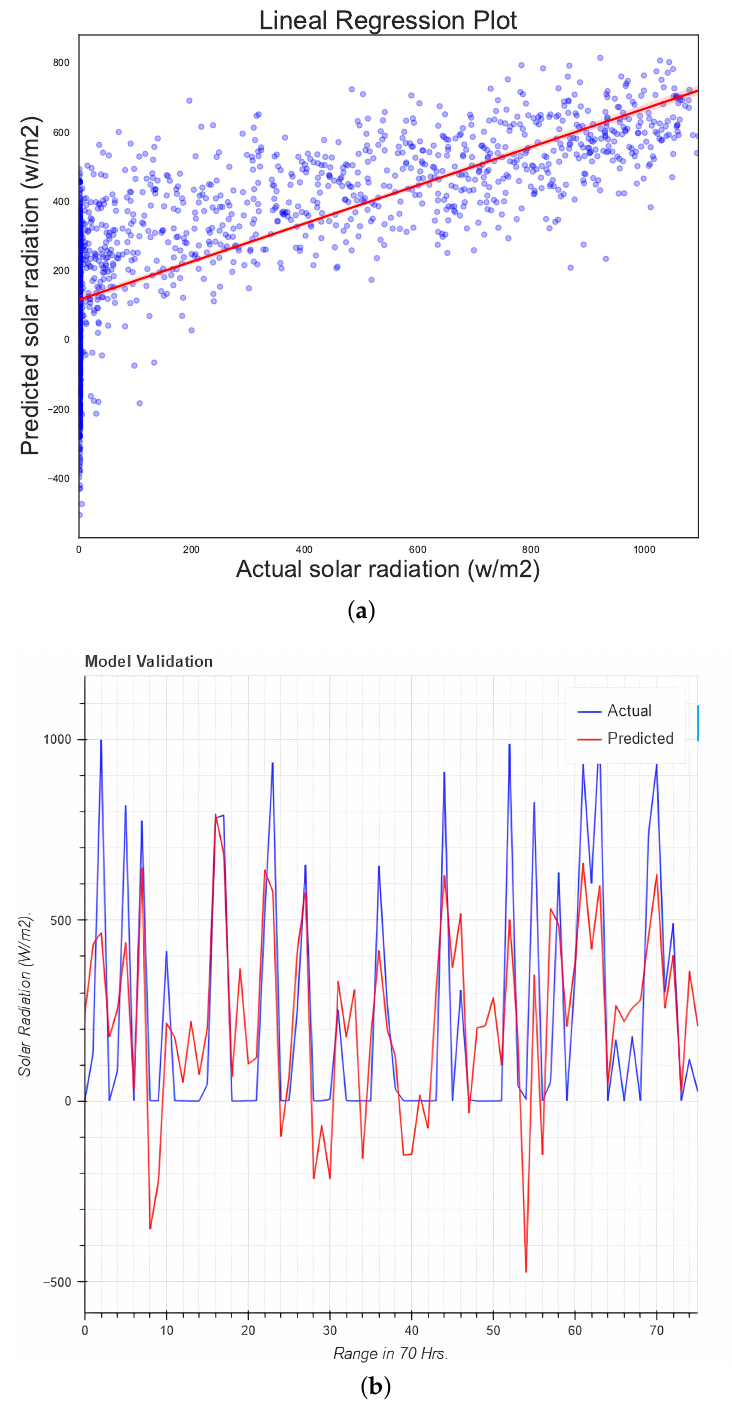
Figure 8. Regression plots for ( a ) the linear regression model and ( b ) the test